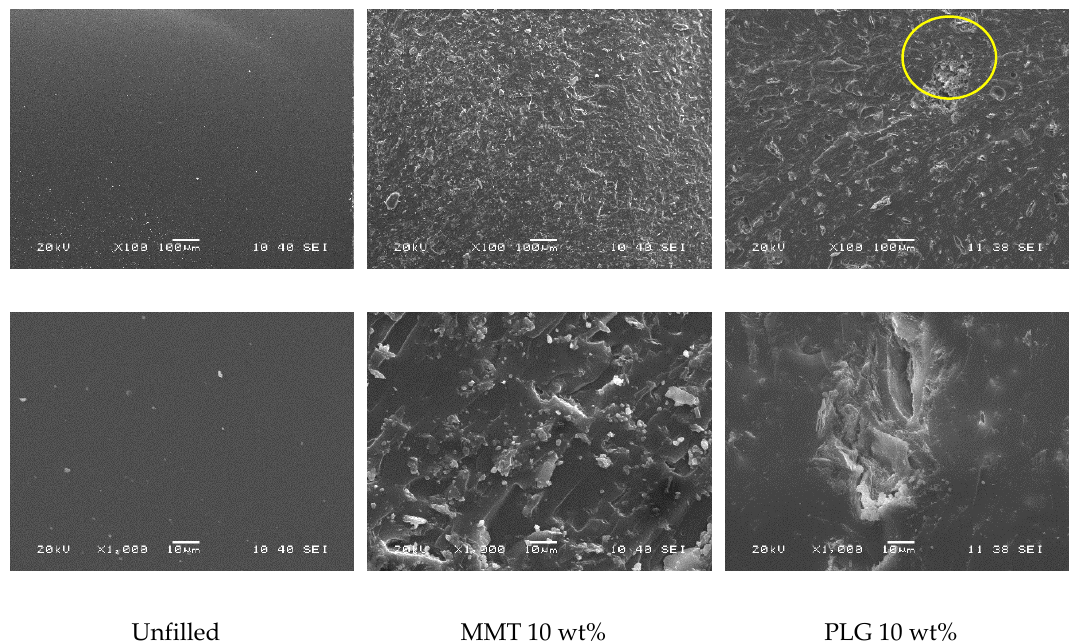
Figure 5. SEM micrographs of fracture surface from bending specimens.